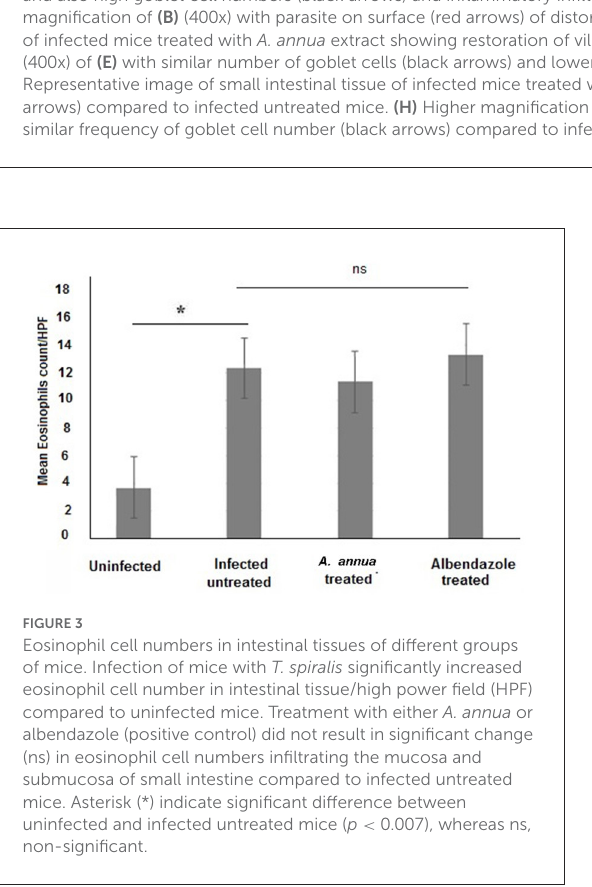
change in numbers of goblet cells compared to infected untreated mice (black arrows) (Figure